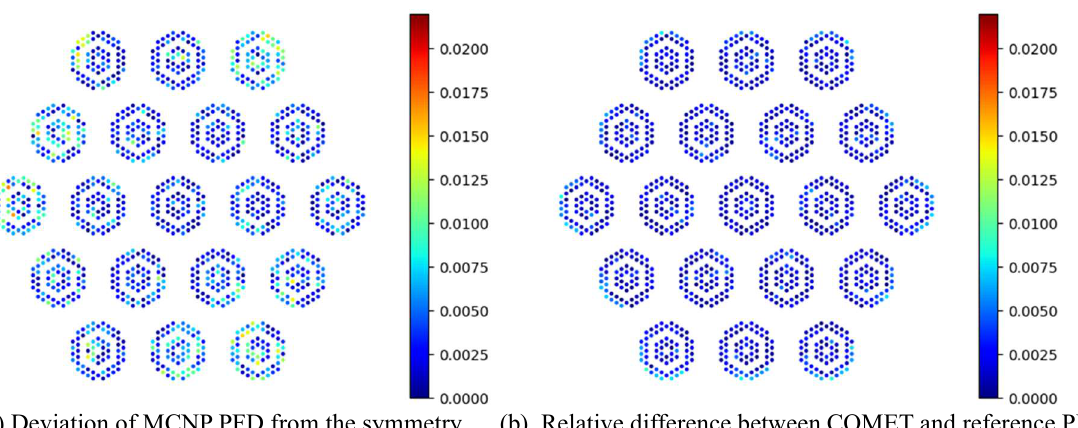
Figure 4. Comparison of the PFD distribution for the ARO core.